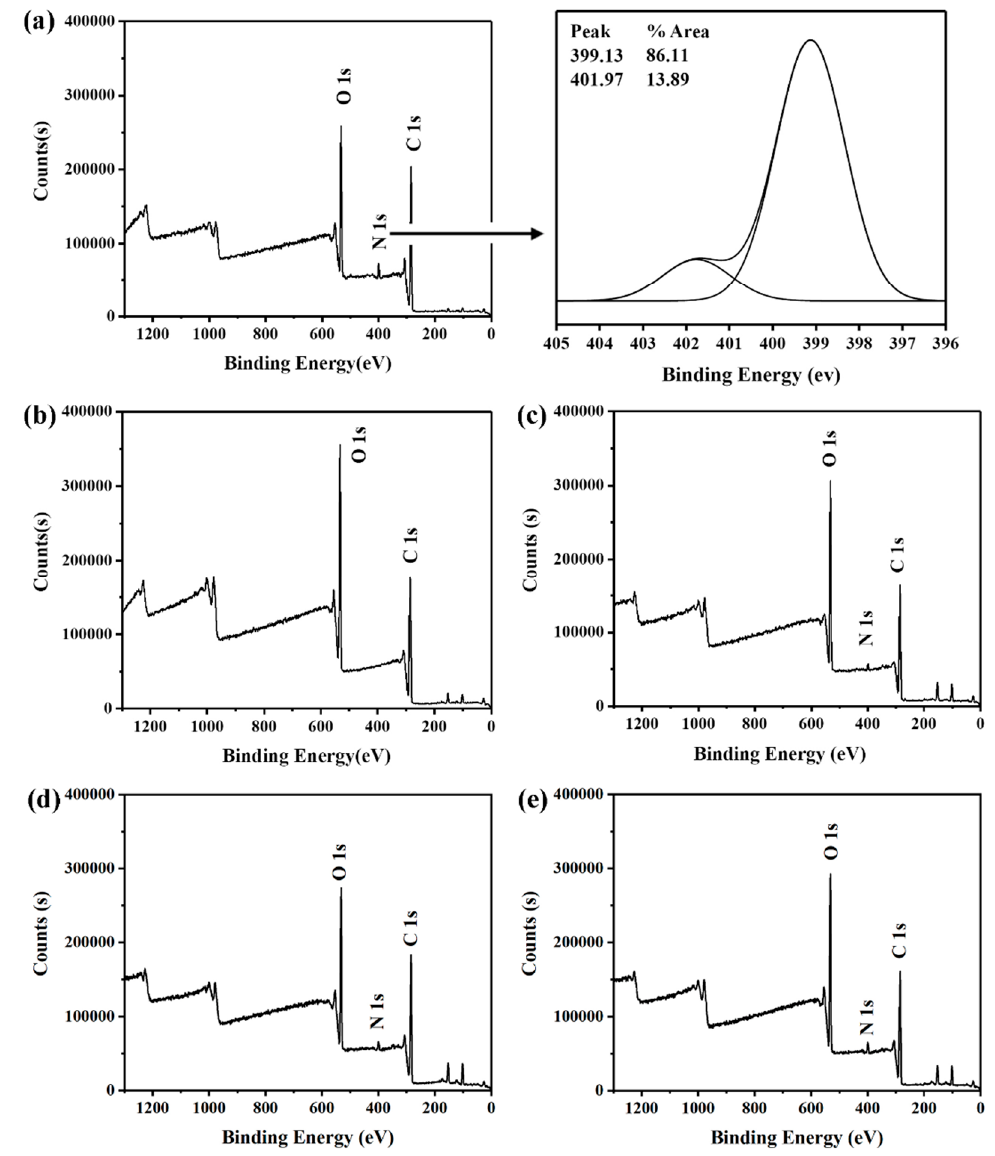
Figure 5. X-ray photoelectron spectroscopy (XPS) spectra: ( a ) CS; ( b ) PLGA; ( c ) CS/PLGA = 0.2; ( d ) CS/PLGA = 0.4; ( e ) CS/PLGA = 0.8.